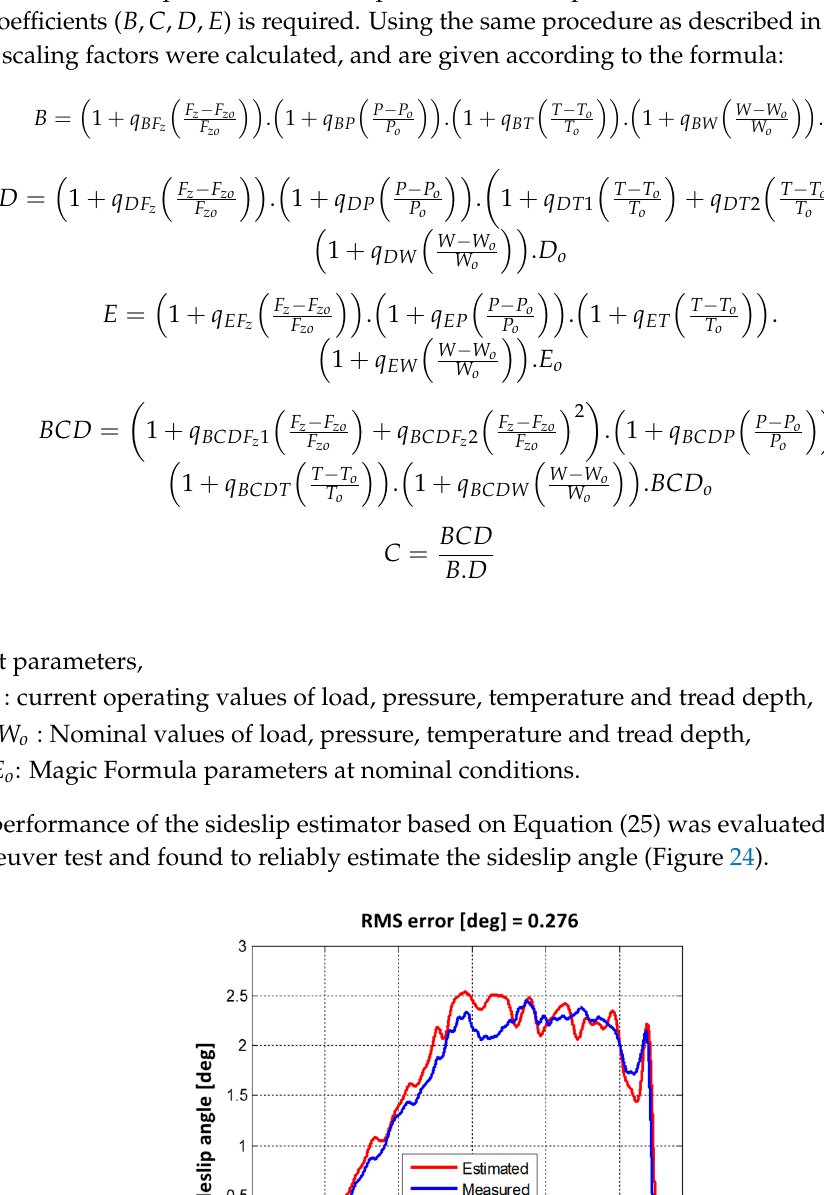
Table 8. State-of-the-Art Literature Review—Intelligent Tires.